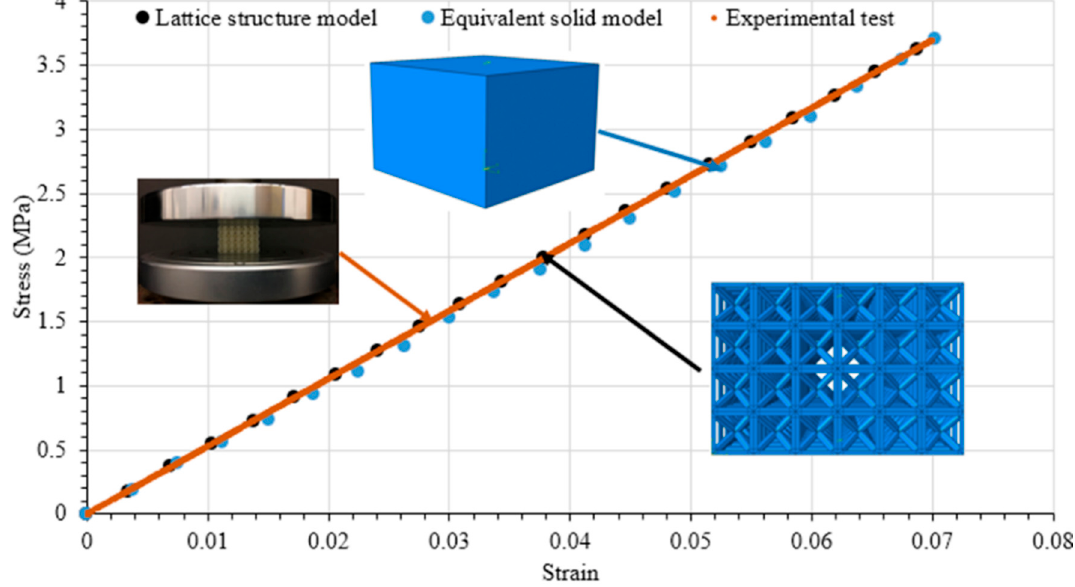
Figure 9. Comparison of the FEA simulation of the LCS model, experimental test, and equivalent solid model.